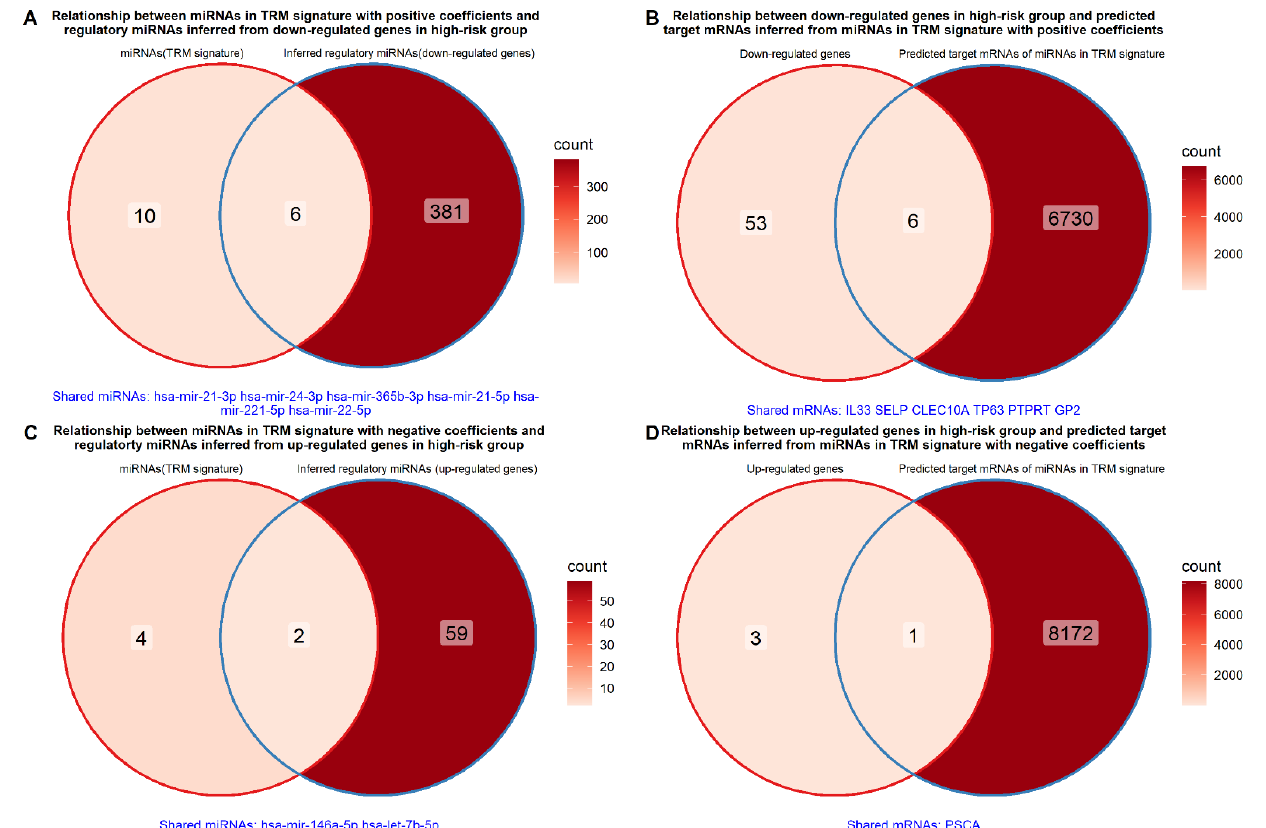
Figure 11. ( A , C ) Venn diagrams displaying relationship between miRNAs in the TRM signature and regulatory miRNAs inferred from the differentially expressed genes. ( B , D ) Venn diagrams displaying relationship between differently expressed genes between the high- and low-risk group and predicted target mRNAs of the miRNAs in the TRM signature.